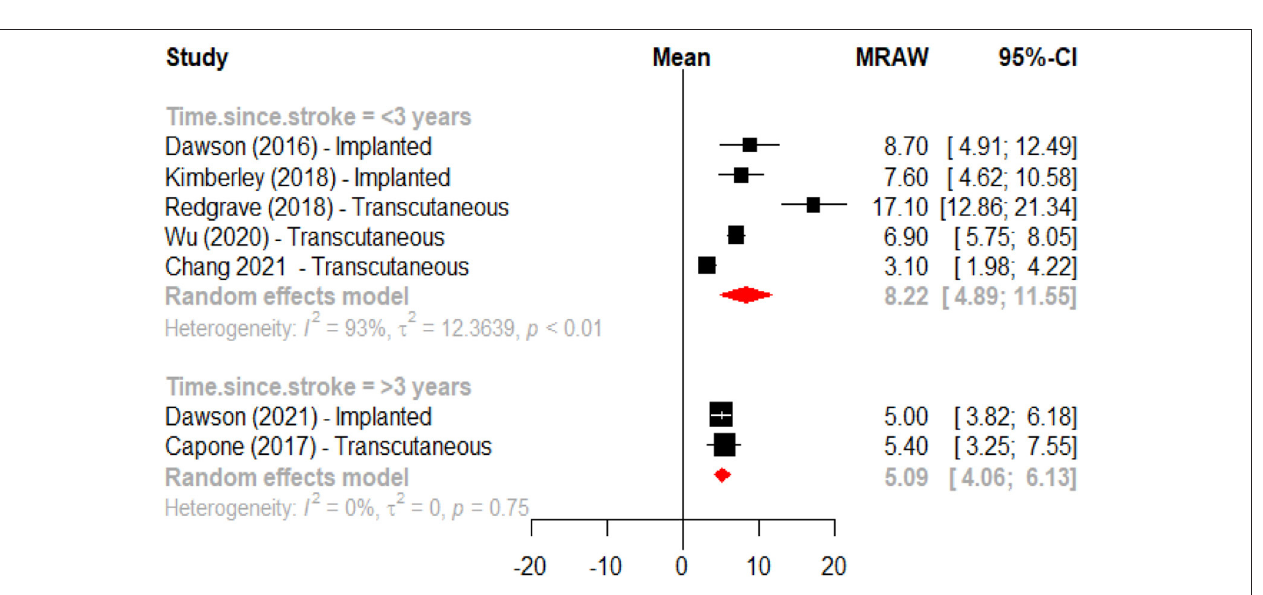
Frontiers in Neurology |